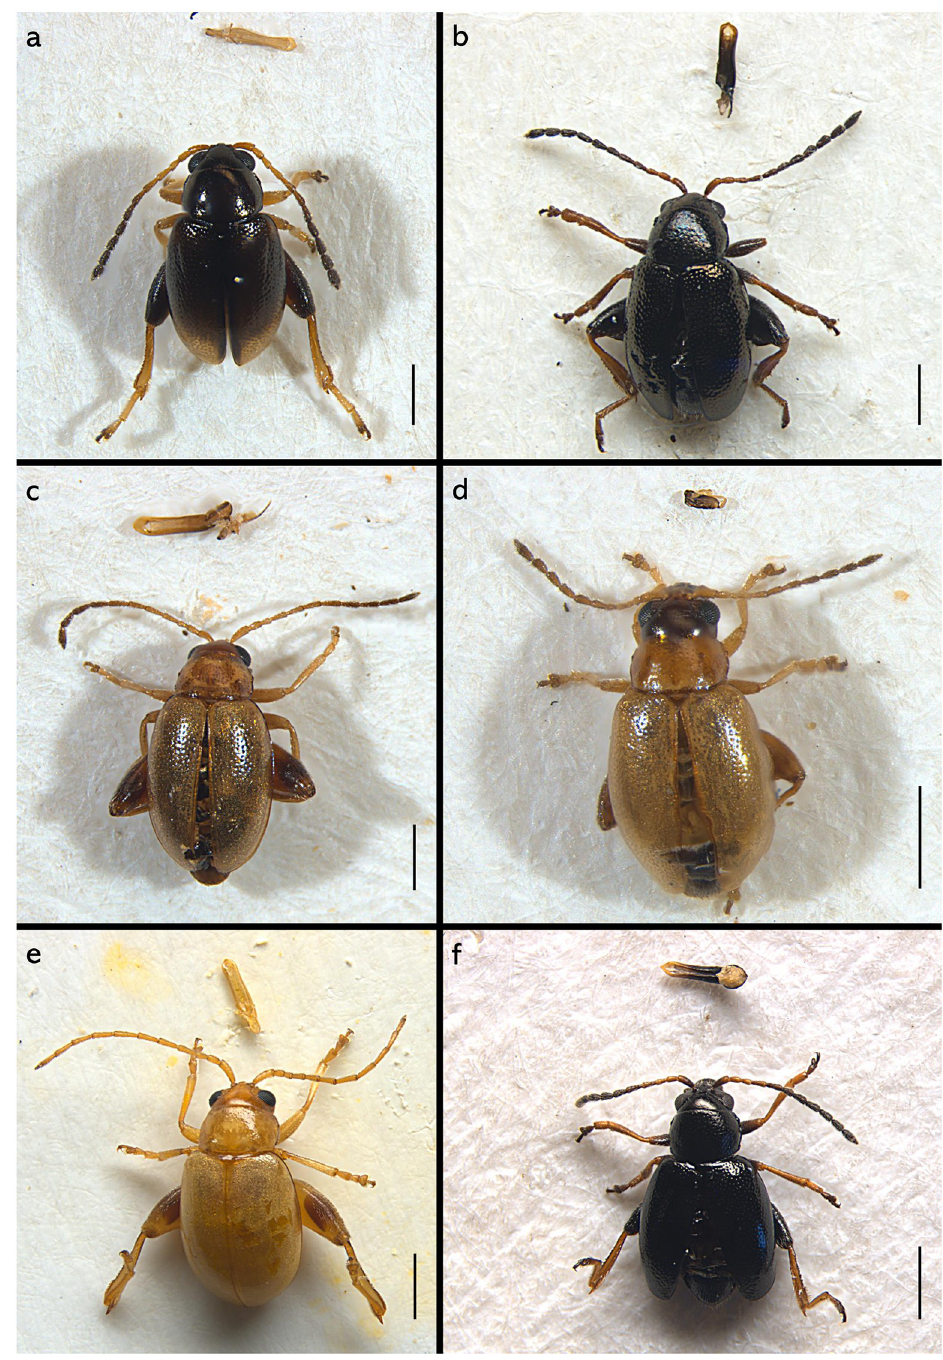
Fig 1. Photographs of voucher specimens of some of the species sequenced in this study (see S1–S3 Figs for photographs of the remaining species). Habitus and aedeagus or spermatheca of (a) Longitarsus aeneicollis ♂ ; (b) L . corynthius metallescens ♂ ; (c) L . ballotae ♂ ; (d) L . pratensis ♀ ; (e) L . candidulus ♂ ; (f) L . anchusae ♂ . Scale bar 0.5 mm.